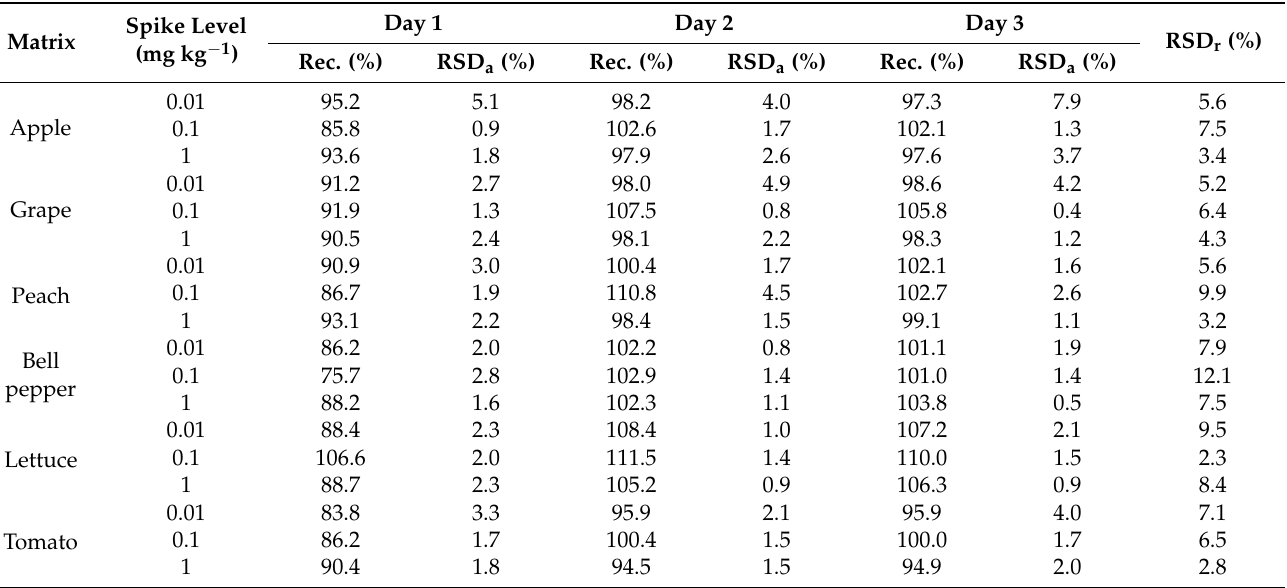
Table 2. Recoveries, RSD a (intra-day, n = 5), and RSD r (inter-day, n = 15) of CYCP from different fruit and vegetable samples analyzed by the developed